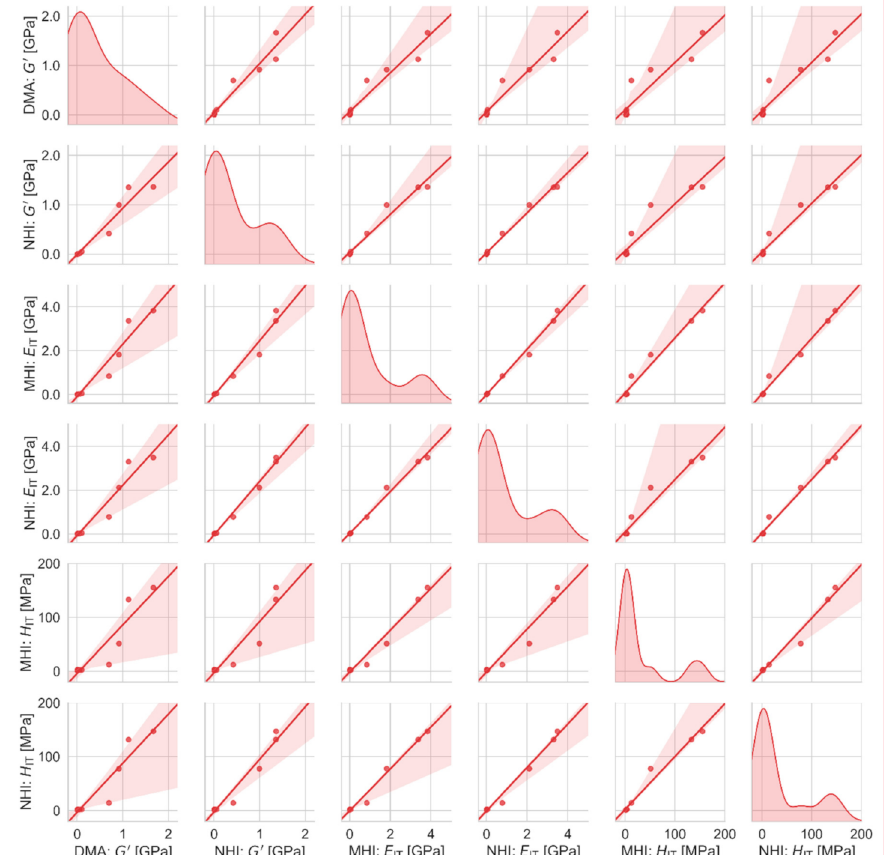
Figure 9. Scatterplot matrix graph showing correlations between selected sti ff ness-related properties in macro-, micro- and nanoscale: storage modulus from dynamic mechanical analysis (DMA / G (cid:48) ), storage modulus from nanoindentation (NHI / G (cid:48) ), indentation modulus from micro- (MHI / E IT ) and nanoindentation (NHI / E IT ), and indentation hardness from micro- (MHI / H IT ) and nanoindentation (NHI / H IT ). Diagonal elements of the scatterplot matrix graph display distributions of the individual quantities. O ff -diagonal elements show linear regression between the pairs of the